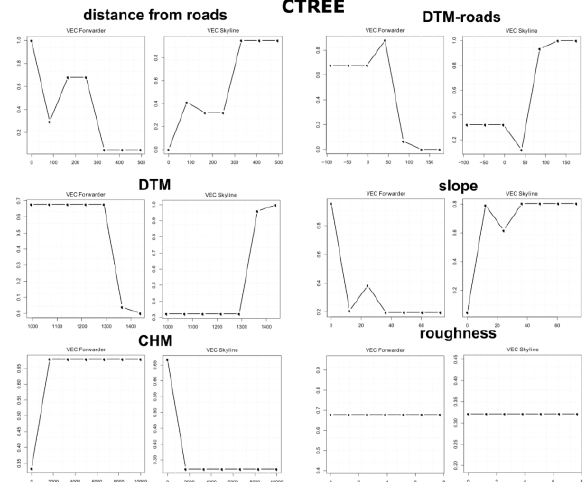
Figure 10 Inputs sensitivity analysis for the two classes of the Ctree